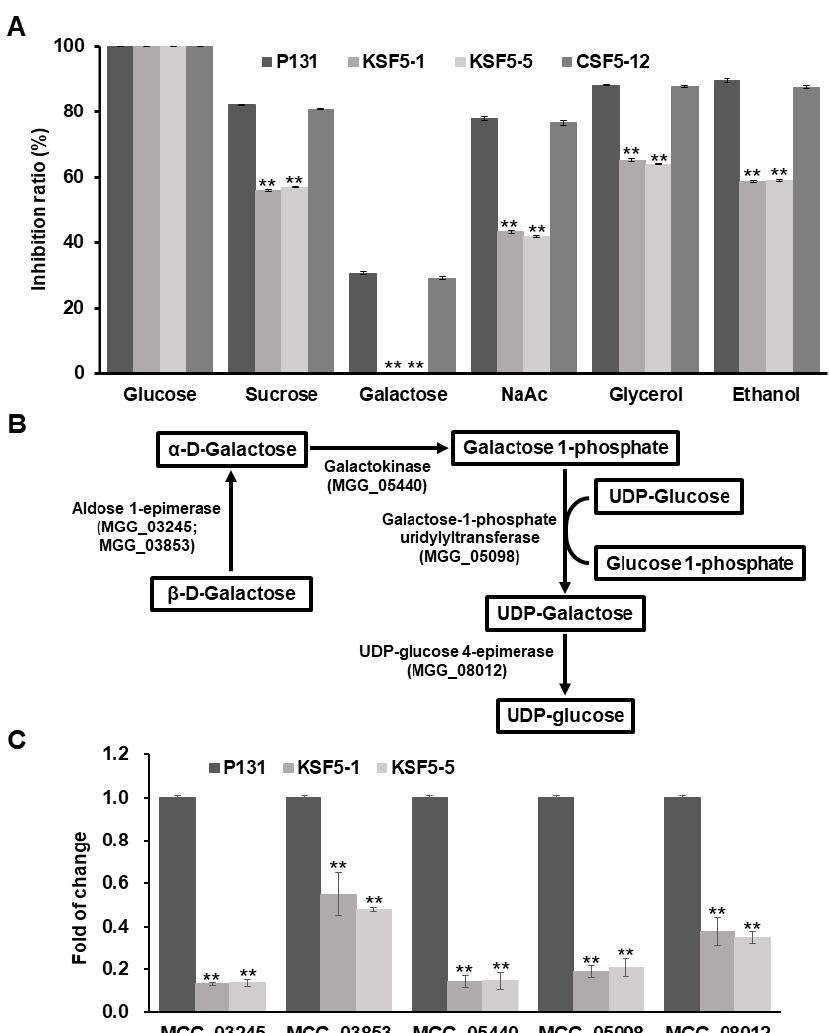
Figure 5. MoSNF5 is required for galactose utilization and regulates expression levels of genes participating in the galactose metabolism pathway. ( A ) Inhibition ratios of the wild-type strain P131, the ∆ Mosnf5 mutants KSF5 − 1 and KSF5 − 5, and its one complementation strain CSF5 − 12 on minimal agar media supplemented with 0.5 M chemical agents, including glucose, sucrose, galactose, NaAc, glycerol, and ethanol, as the sole carbon source. The mean and standard deviations were calculated based on three independent experiments by measuring three plates in each replicate. Asterisk marks a significant difference between the mutants and the P131 strain by using t -test ( p < 0.05). ( B ) The scheme of the galactose catabolism pathway with four enzymes. Aldose 1-epimerase, MGG_03245 and MGG_03853; galactokinase, MGG_05440; galactose-1-phosphate uridylyltransferase, MGG_05098; UDP-glucose 4-epimerase, MGG_08012. ( C ) Relative expression levels of the six genes participating in the galactose catabolism pathway between strains P131 and the ∆ Mosnf5 mutants KSF5 − 1 and KSF5 − 5. The expression level of each gene in strains P131, KSF5 − 1, and KSF5 − 5 was normalized against that of the Actin gene, and the expression level of each gene in strain P131 was arbitrarily set to 1. The mean and standard deviations were calculated based on two independent experiments. Asterisk marks a significant difference between the mutants and the P131 strain by using t -test ( p <